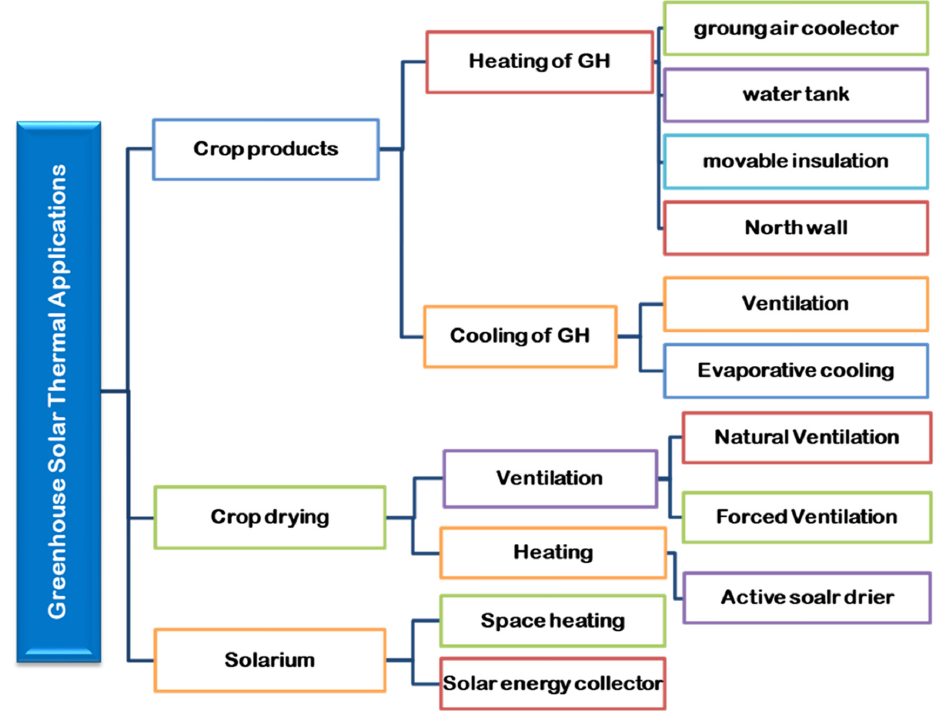
Figure 2. Broader classification of greenhouse solar thermal